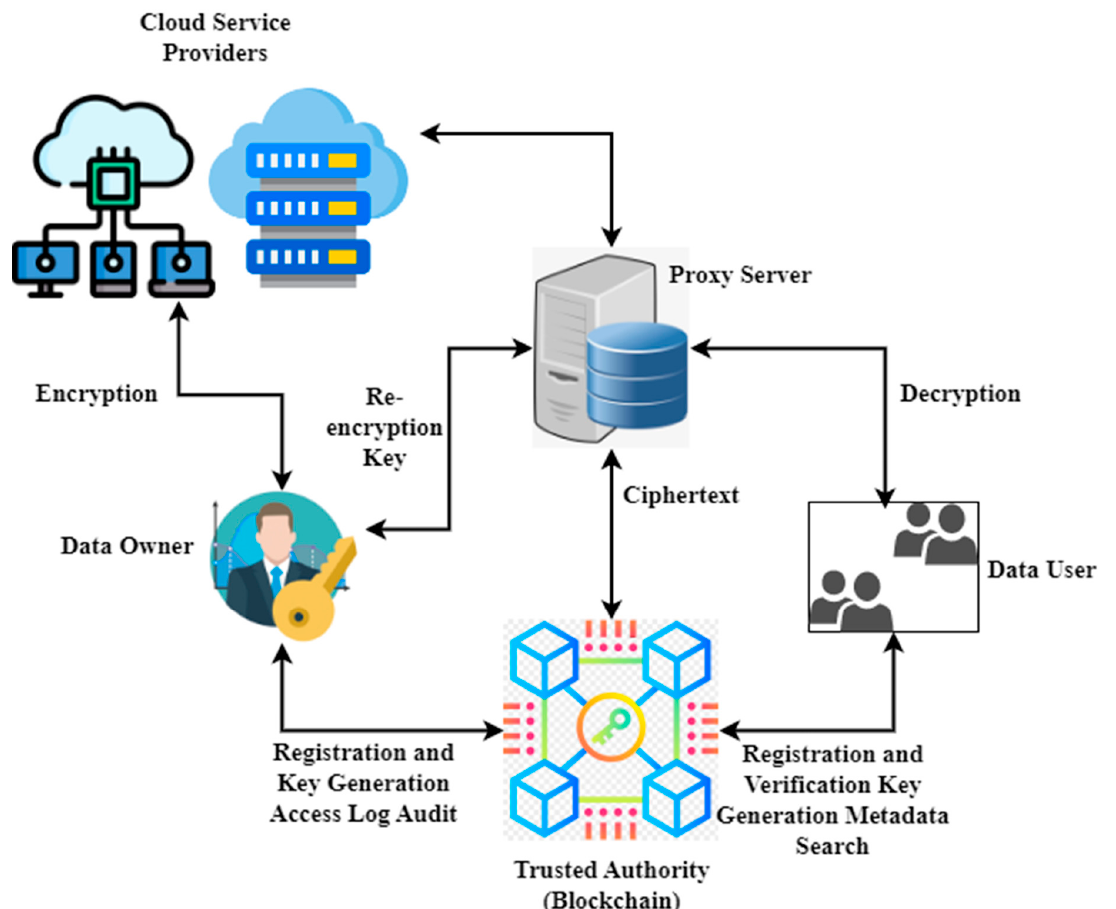
Figure 2. Cybersecurity information sharing (CIS) model.